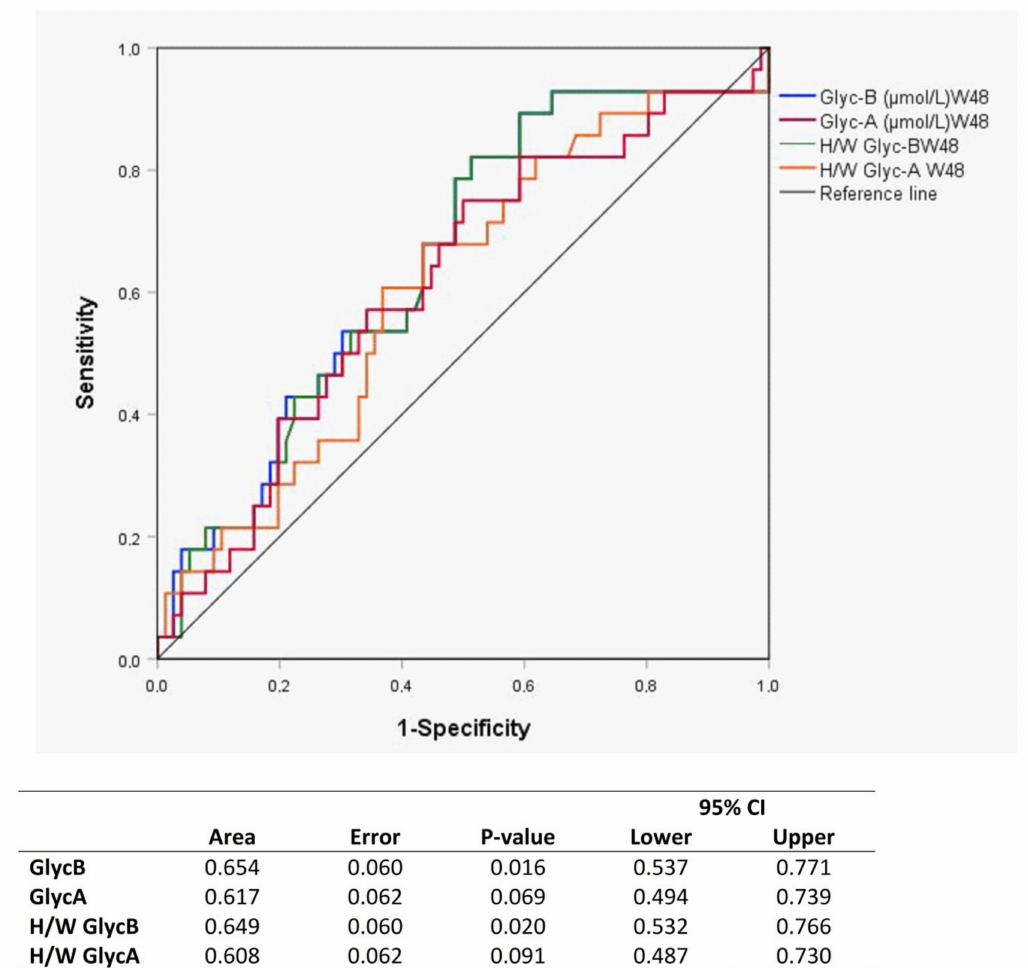
Figure 4. ROC curves of each glycoprotein as a predictor biomarker of immunological response to ART at week